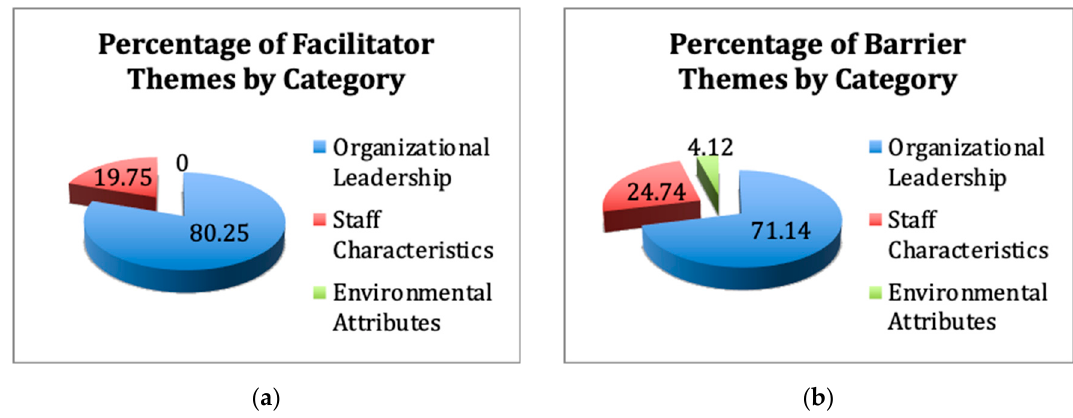
Figure 4. ( a ) and ( b ) Percentage of facilitators and barriers by theme category.